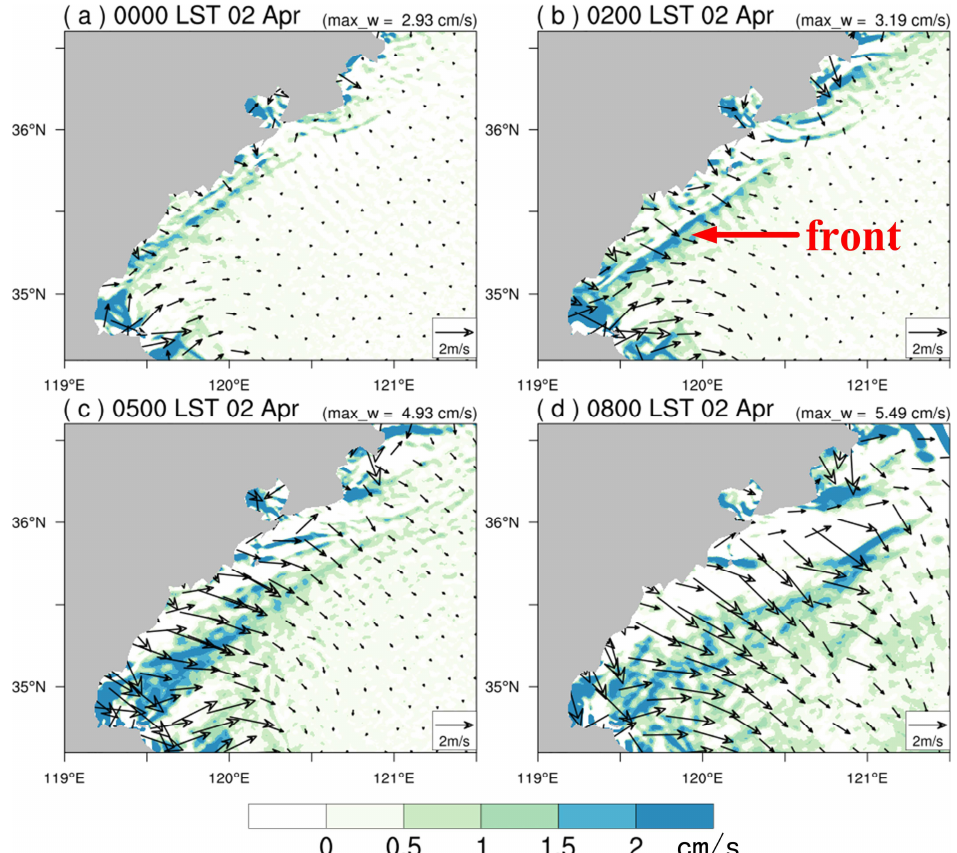
Figure 11. Horizontal expansion of the land breeze circulation that is shown by both 10-m winds (black vectors) and vertical speeds (shades) averaged within 100–600 m from the result of Exp-Ctrl minus Exp-LB0. The information of time and maximum vertical velocity are shown at the top of the panels ( a – d ).